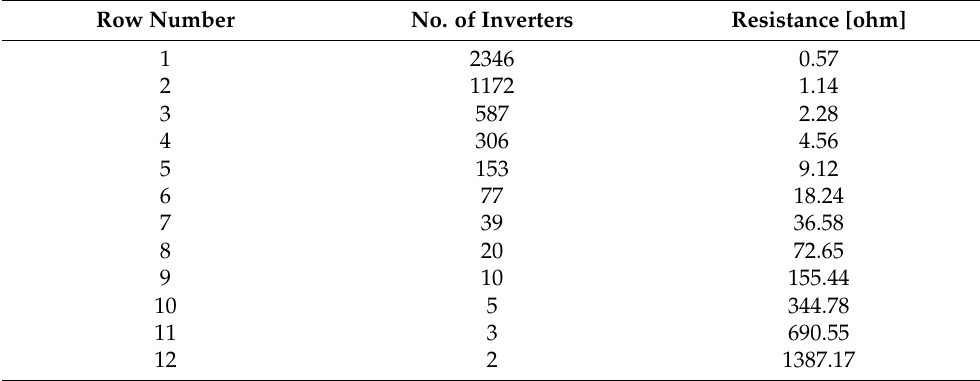
Table 1. Relationship between number of inverters and supply track resistance for each row of the designed structure.